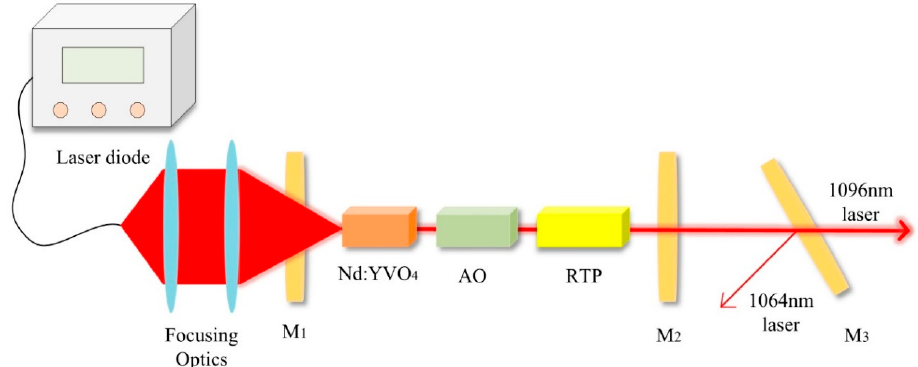
Figure 1. Schematic diagram of the diode-pumped actively Q-switched Nd:YVO 4 /RTP intracavity Raman laser.